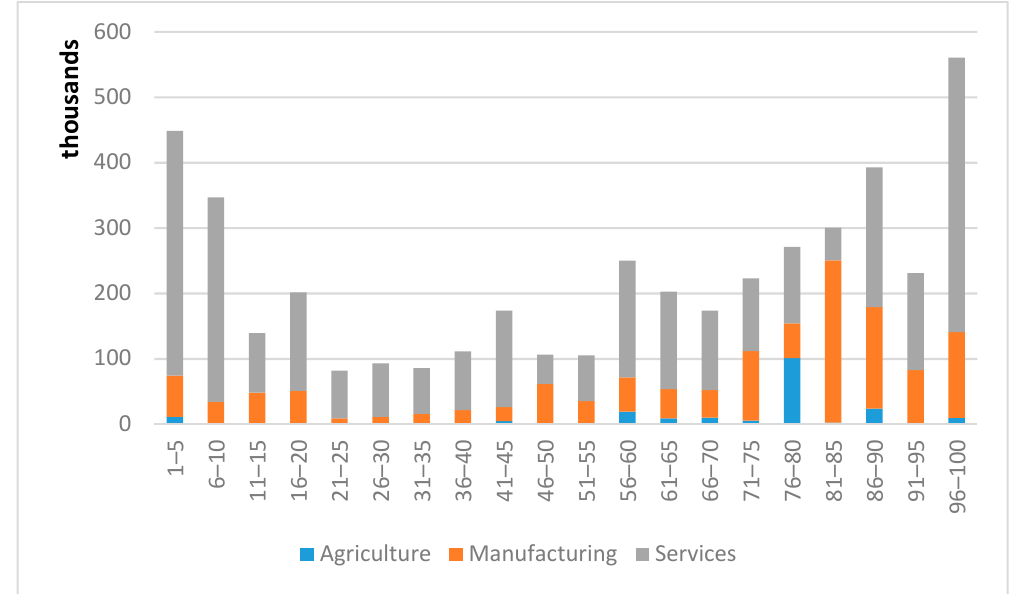
Figure 2. Breakdown of employees by susceptibility to automation and industry per person in 2016. Source: Microcensus 2016.